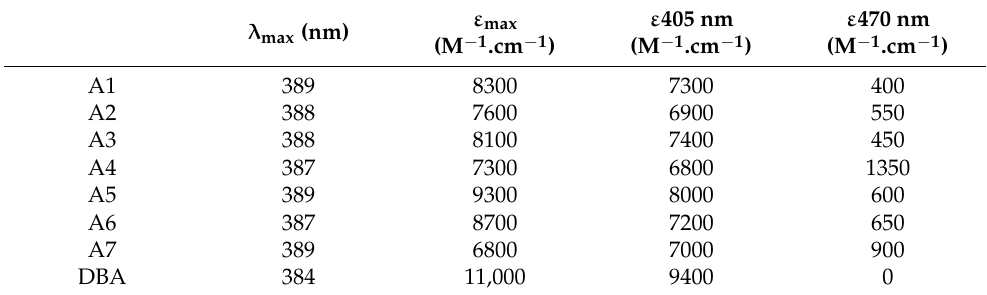
Figure 16. UV-visible absorption spectra of A1–A7 in acetonitrile. Reproduced with permission of Ref. [148] .